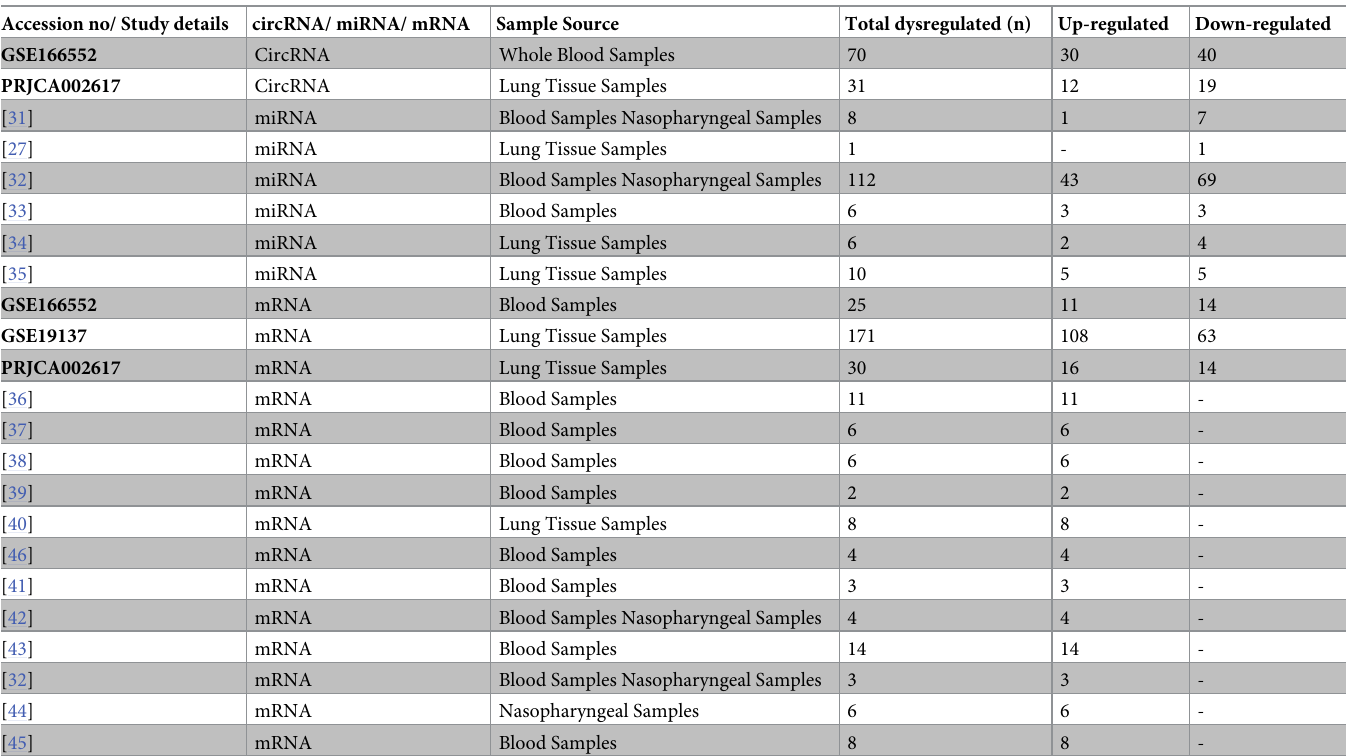
Table 1. Datasets used for retrieving expression profiles of circRNAs, miRNAs and